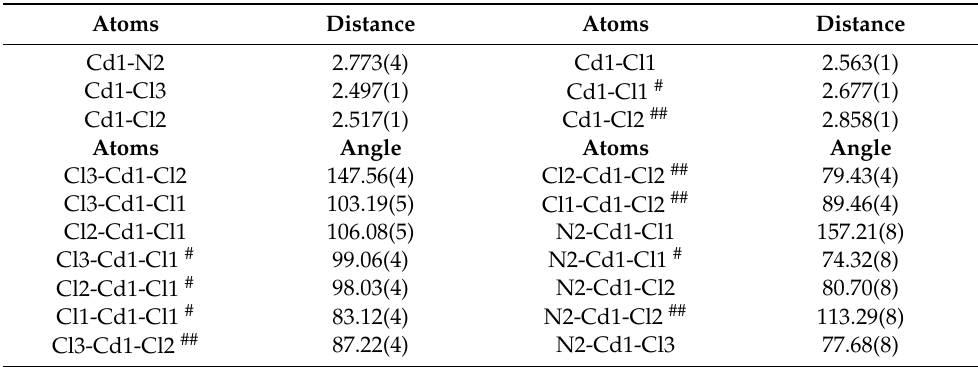
Table 2. Bond distances (Å) and angles (°) for 1 . Atoms Angle Atoms Angle Cl3-Cd1-Cl2 147.56(4) Cl2-Cd1-Cl2 ##